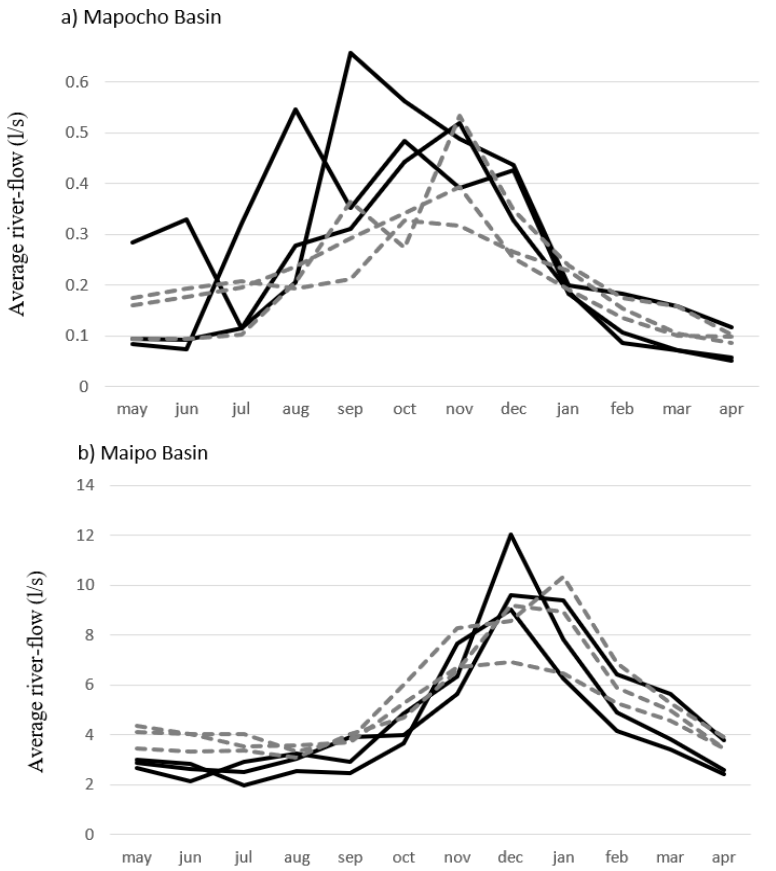
Figure 6. Average river-flow for high (solid lines) and low occurrence (dotted lines) of rain-on-snow event, for the Maipo ( a ) and Mapocho ( b ) sub-basins.